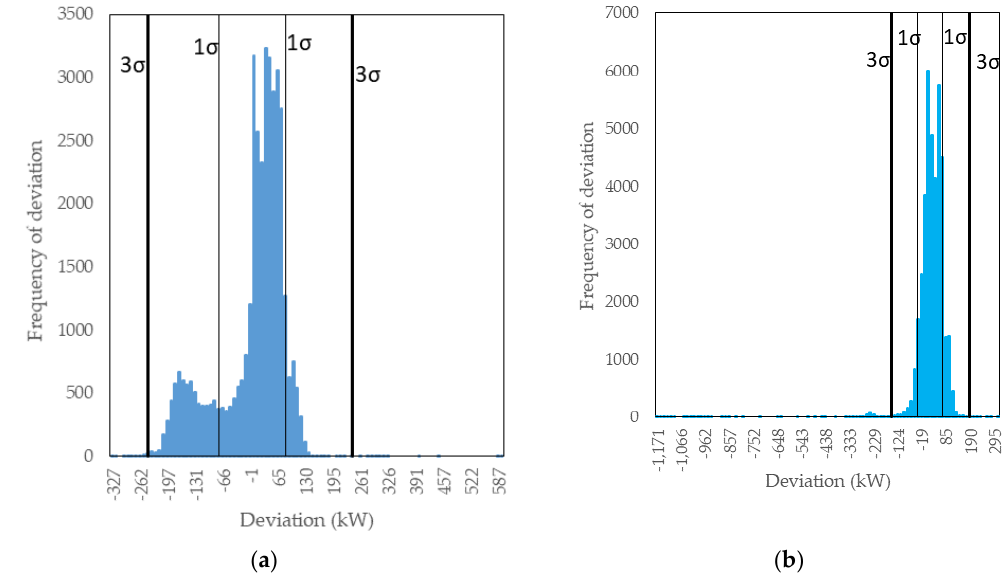
Figure 4. Histogram of deviation between analytical and measured loads for BH group A ( a ) and B ( b